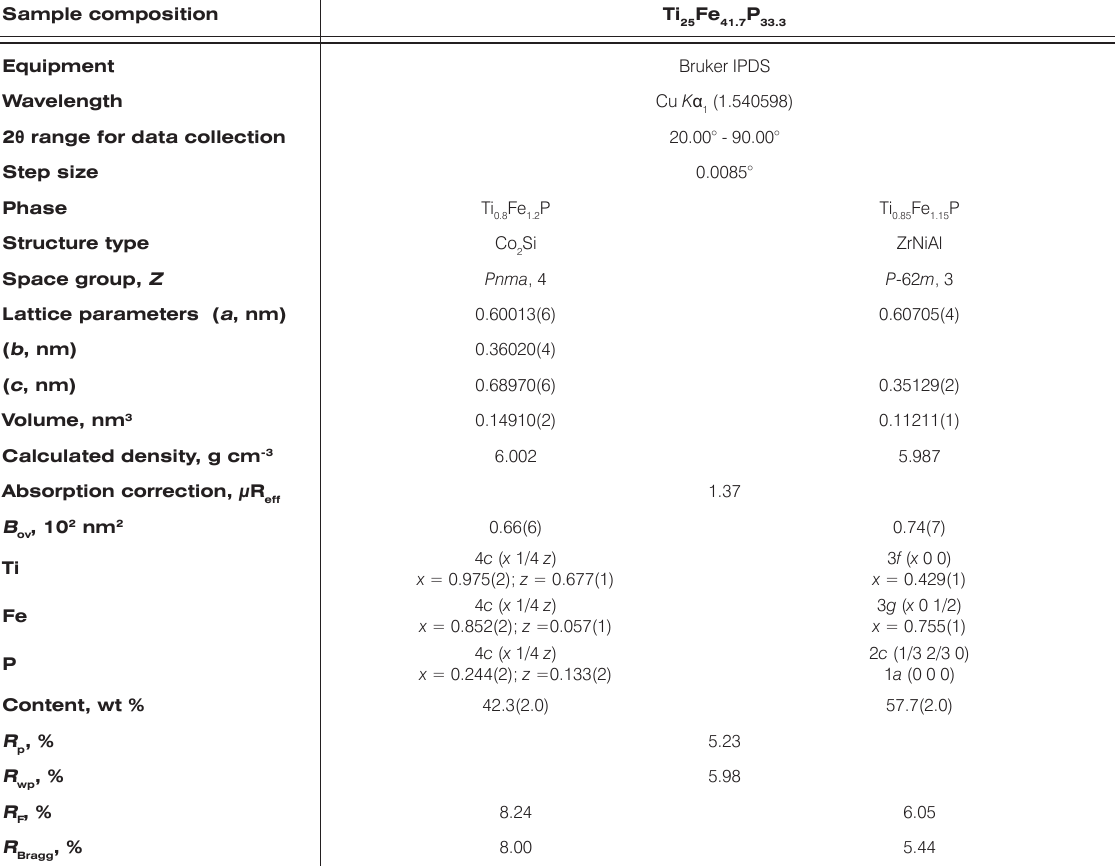
Fe P (Co Si-type) and Ti Fe P (ZrNiAl-type) 0.5-0.8 1.5-1.2 2 0.85-1.25 1.15-0.75 Fe P sample. 25 41.7 33.3